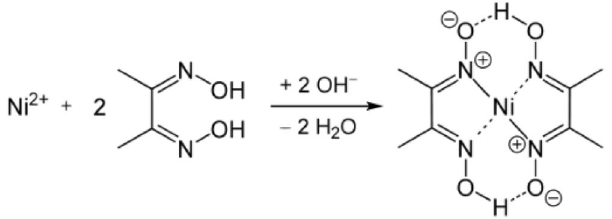
Figure 1. Structure of DMG and DMG-Ni. Two molecules of DMG are needed to coordinate one molecule of Ni 2 +